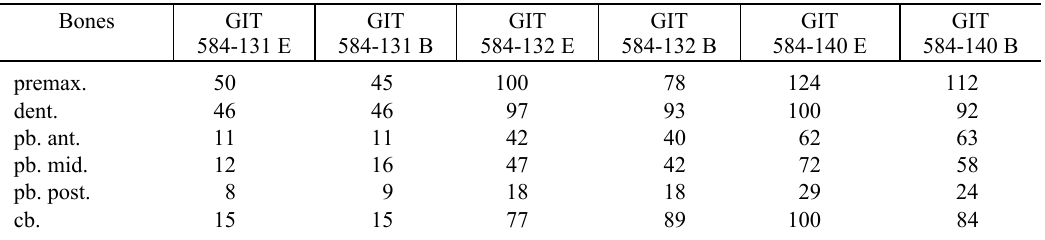
Table 3. Approximate numbers of teeth on jaws and pharyngeal tooth plates of the turbot Scophthalmus maximus . Abbreviations: pb., pharyngobranchial; cb., ceratobranchial; dent., dentary; premax., premaxilla; E, eye side; B, blind